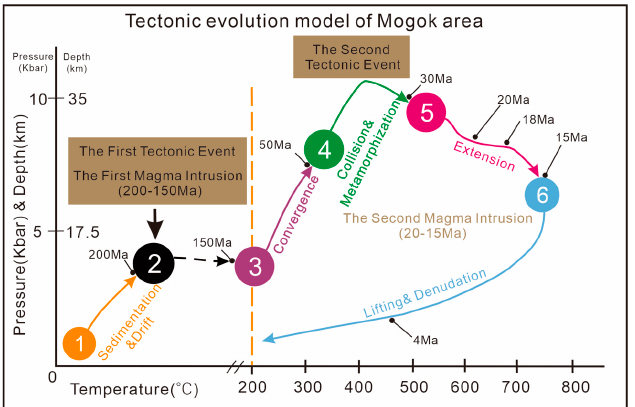
Figure 14. Tectonic evolution model of Mogok area (modified from Themelis et al., 2008) [37].